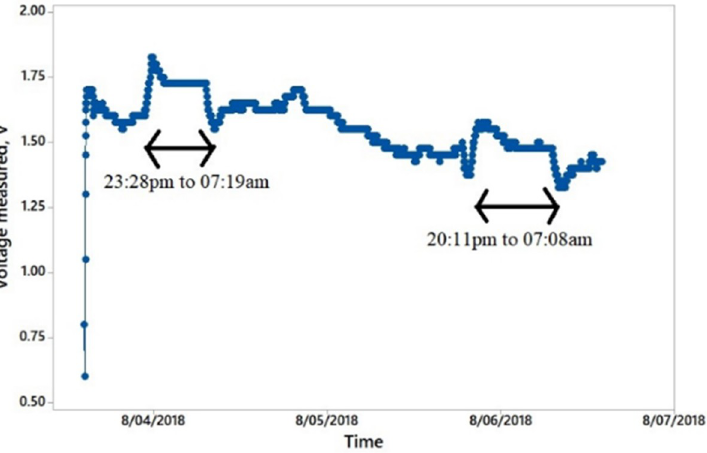
Fig 20. Voltage value of a capacitor, which is charged by a series connection of cut off leaves disconnected from the plant over a period of 3 days.